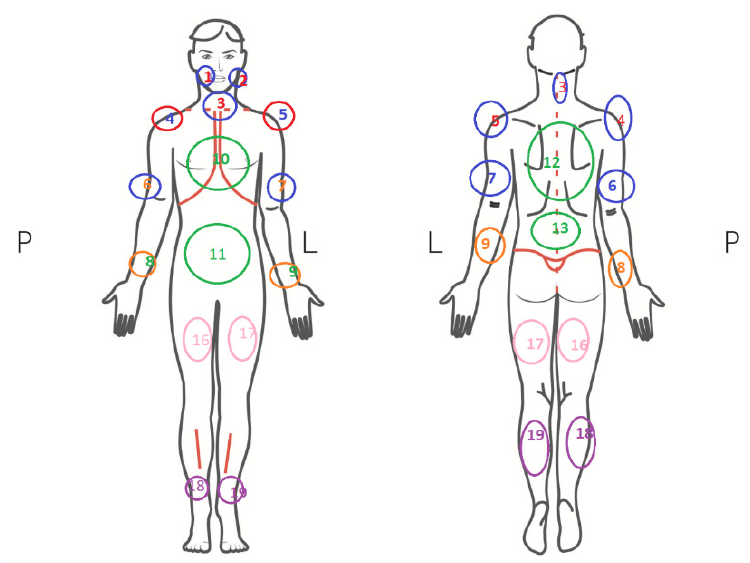
Figure 2. Tender points of the muscles in fibromyalgia [12].